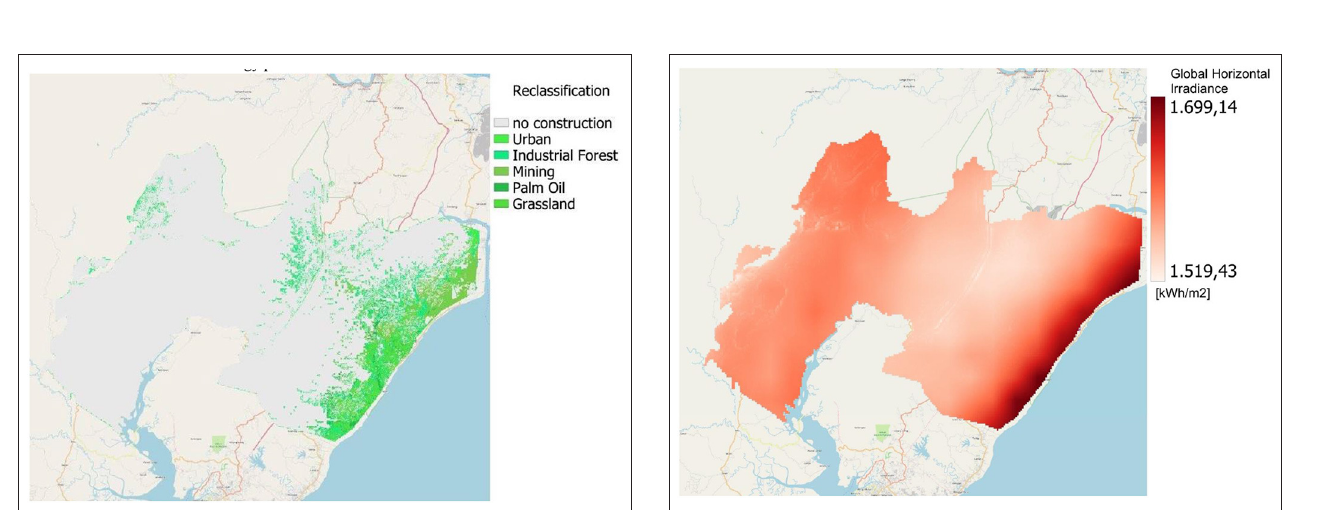
FIGURE 8 | Wind energy potential with the exclusion of significant land use, high slopes, and protected wetlands.